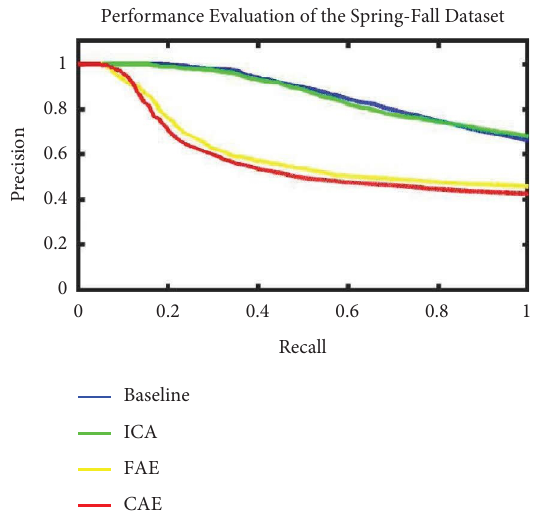
Figure 14: Precision-recall curves of the baseline and proposed algorithms on the spring-fall dataset.